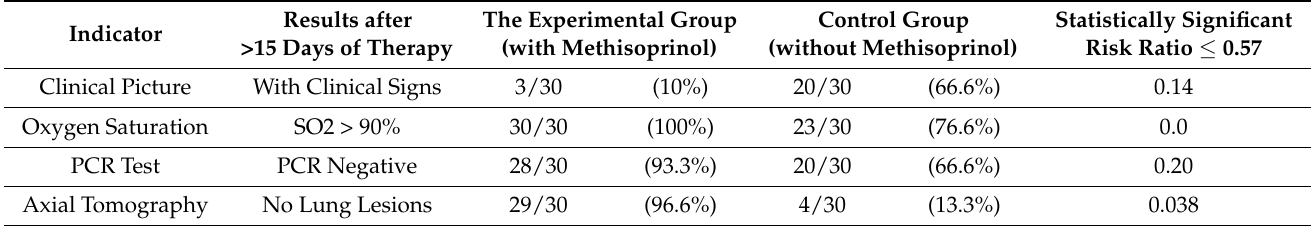
Table 1. Endpoints in a clinical study by Borges et al., 2020